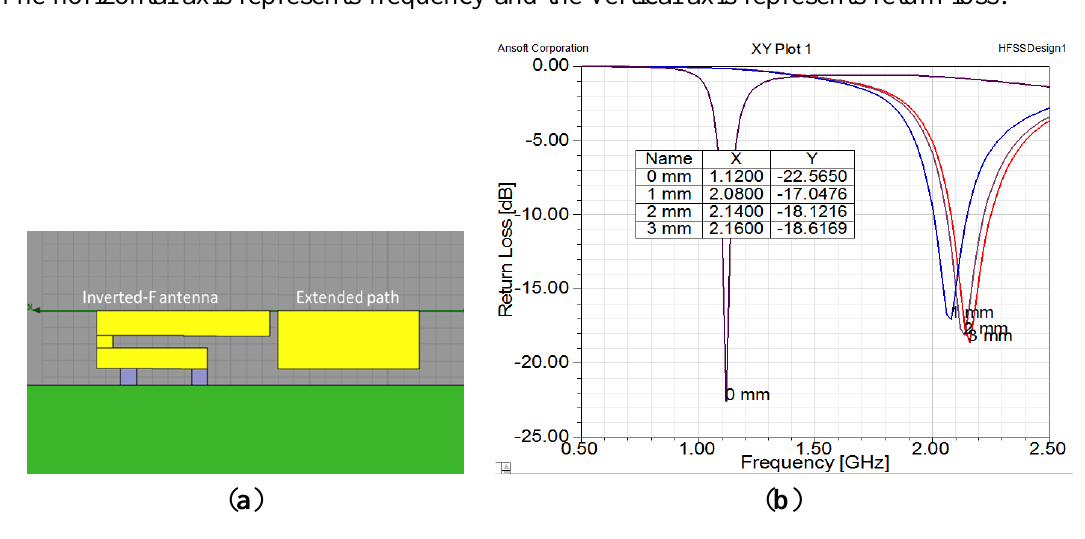
Figure 7. ( a ) Design of extended path; ( b ) Optimization of gap between two antenna strips. The horizontal axis represents frequency and the vertical axis represents return loss.